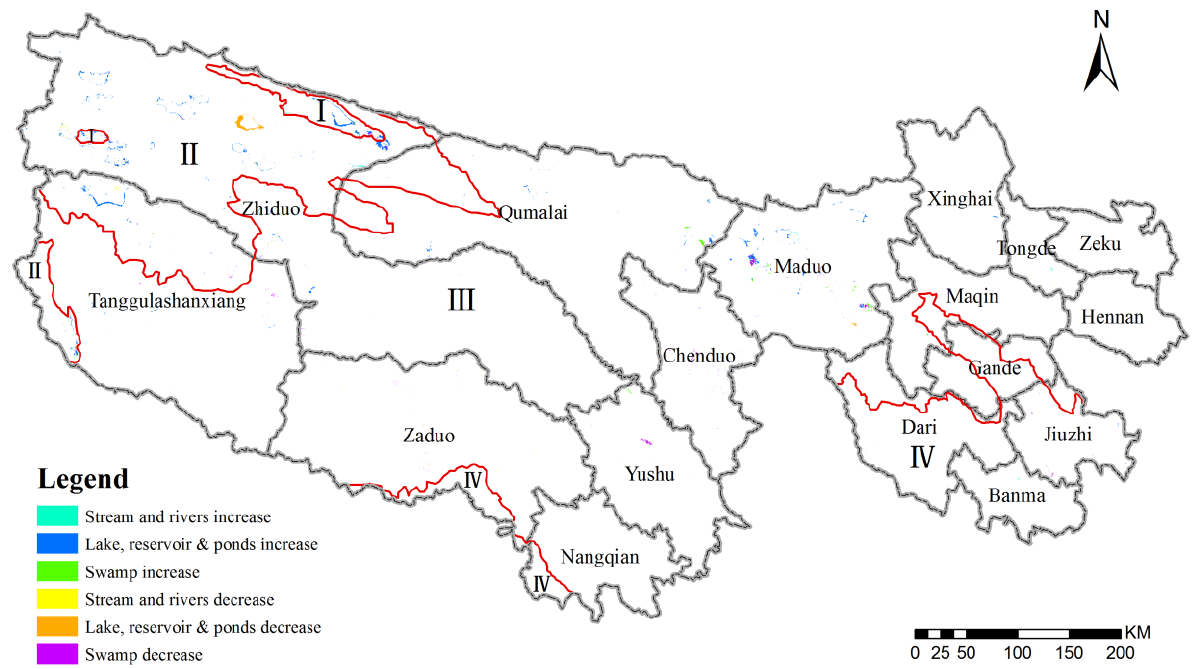
Figure 5. The distribution of wetland changes in the TRH region from 2004 to the early 2012 (humidity Region I: 0.3–0.4; II: 0.4–0.5; III: 0.5–1; and IV: